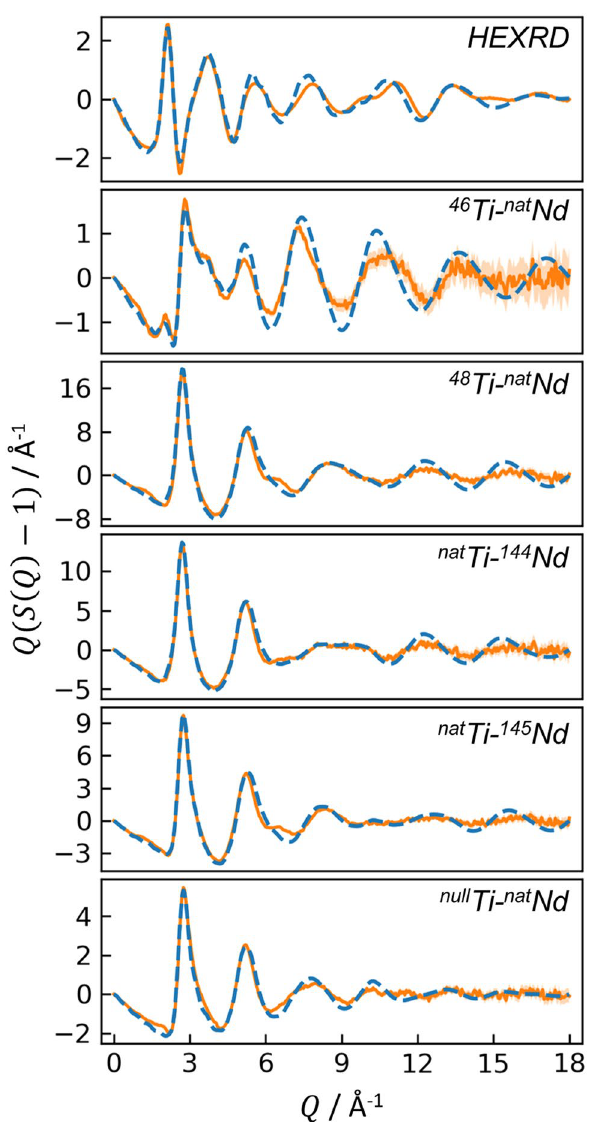
Figure 2. Interference functions for the HEXRD and five ND measurements. Solid orange curves are the experimental data, with uncertainty shown by light orange shading; dashed blue curves are the EPSR